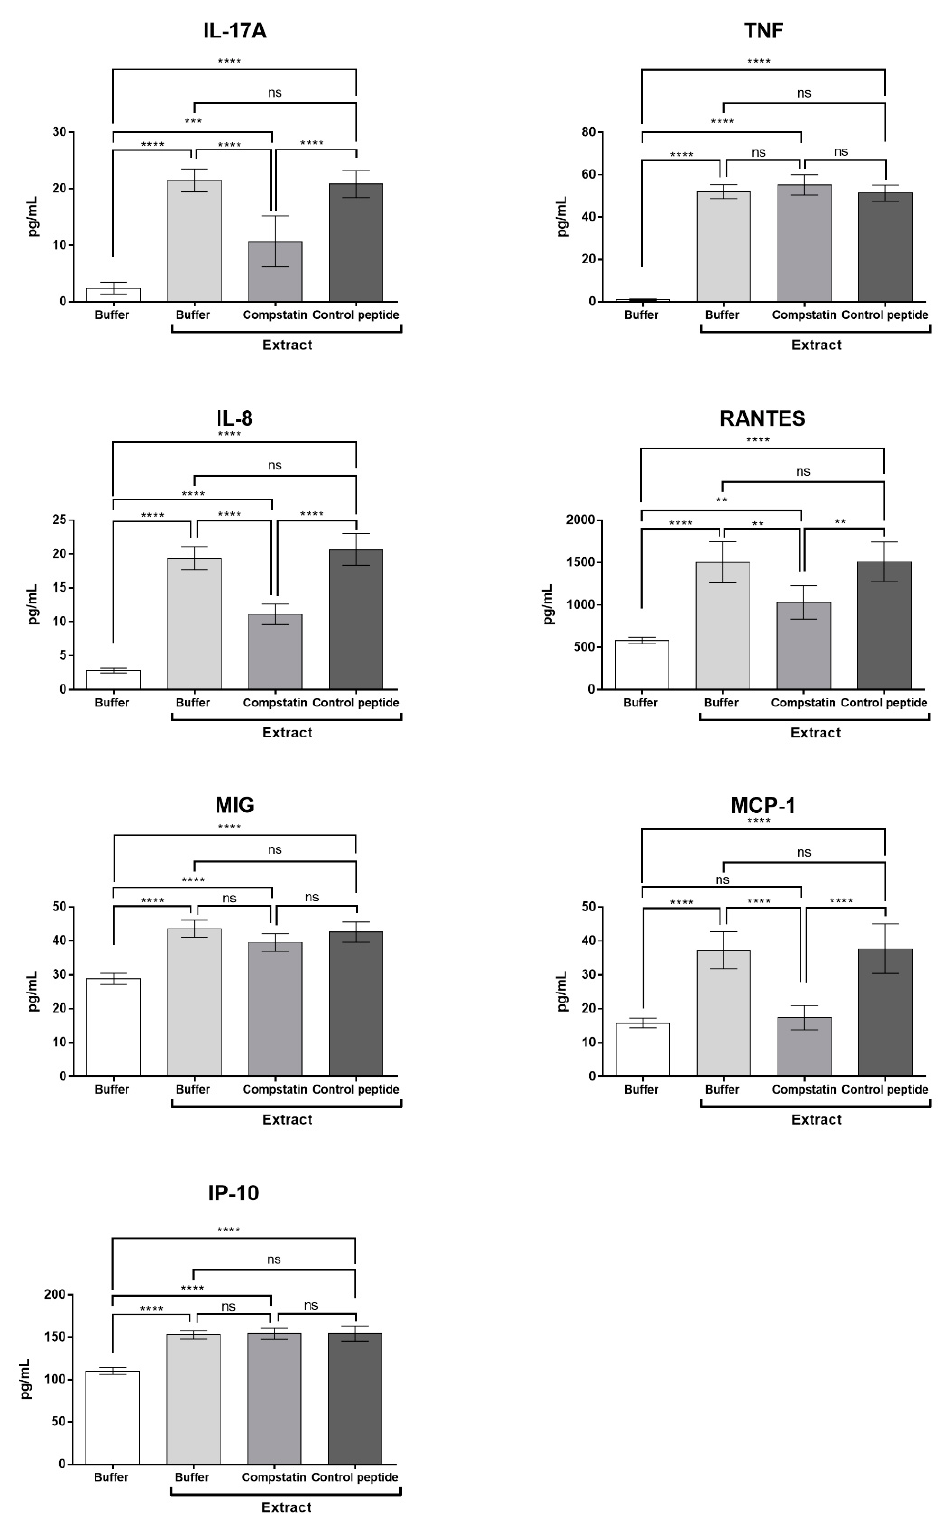
Figure 6. Cytokine and chemokine levels in whole blood stimulated with Pararama hair extract in the presence of compstatin. Human blood samples anticoagulated with lepirudin (50 µ g/mL) were preincubated with PBS, compstatin (50 µ M), or control peptide (50 µ M) and then incubated with Pararama hair extract (95 µ g/mL) or PBS for 30 min at 37 ◦ C. After plasma collection, the production of cytokines and chemokines was determined by flow cytometry. The results are presented as the mean ± SD of